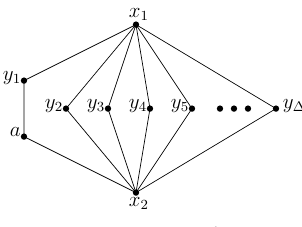
Figure 1. The graph ˆ K 2, ∆